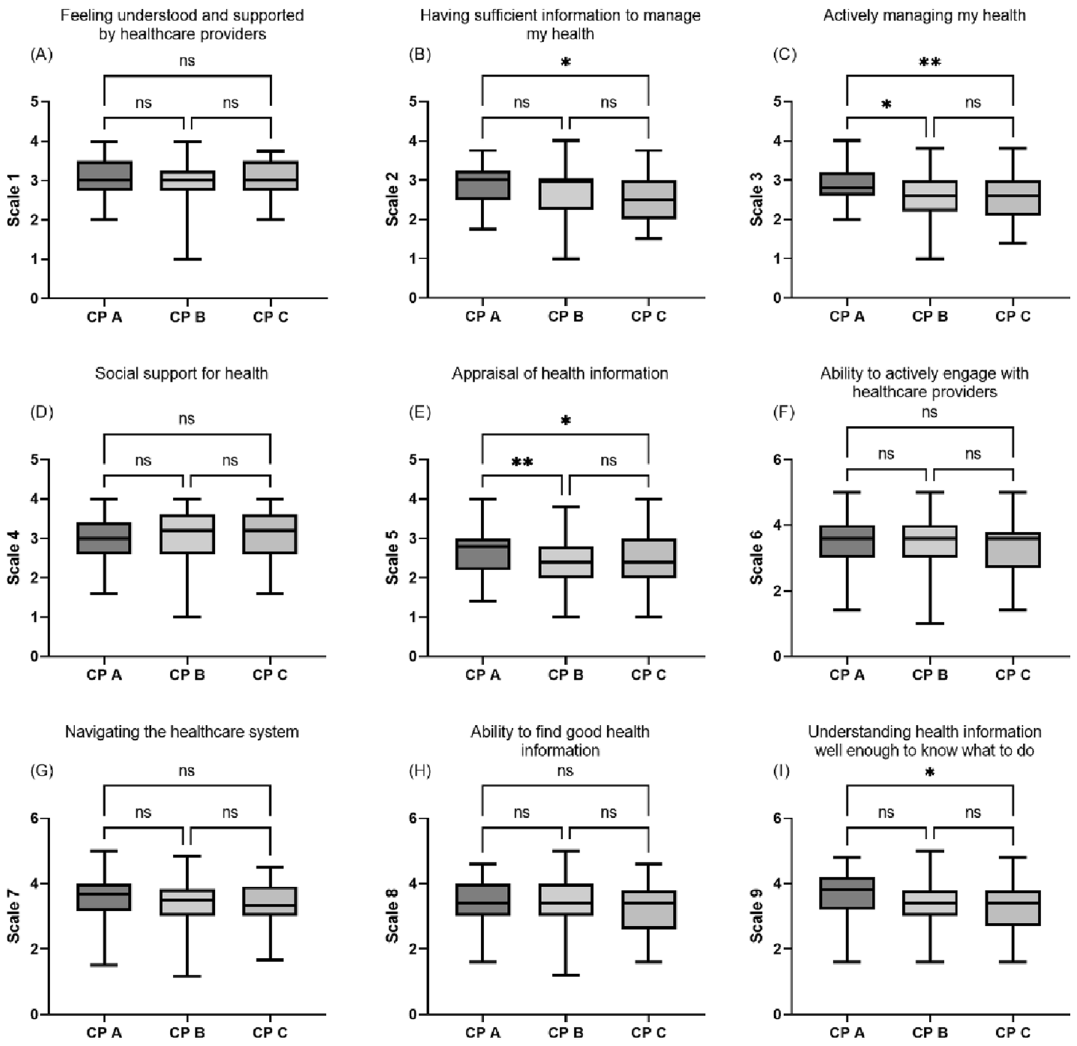
Figure 2. Comparison of the scores in the nine subscales of the HLQ between patients with liver cirrhosis Child–Pugh A, B and C. *p < 0.05, ** p < 0.01, ns = not significant. Comparisons of three groups were performed using an ANOVA followed by Tukey’s multiple comparison